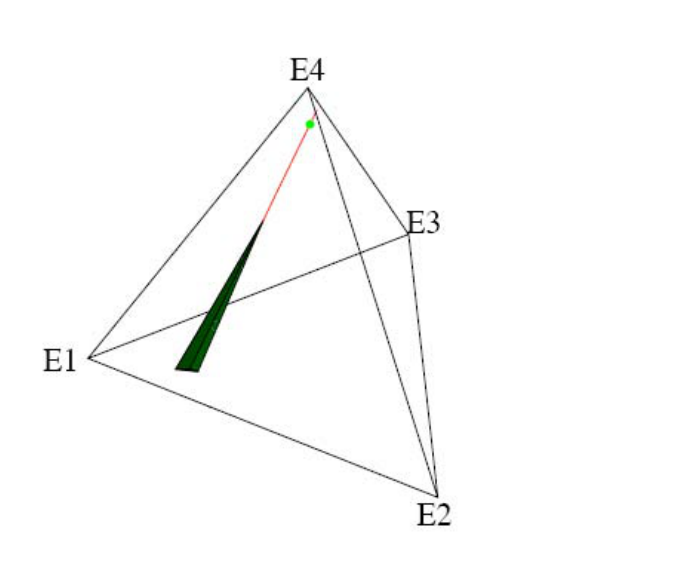
for the line segment spanned 234